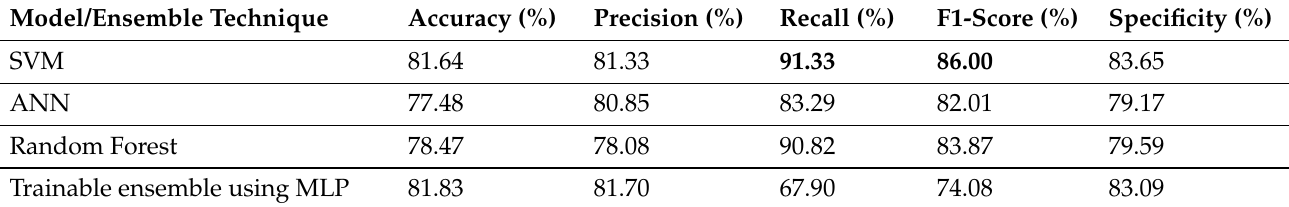
Table 5. Classification performances obtained by standard classifiers and their